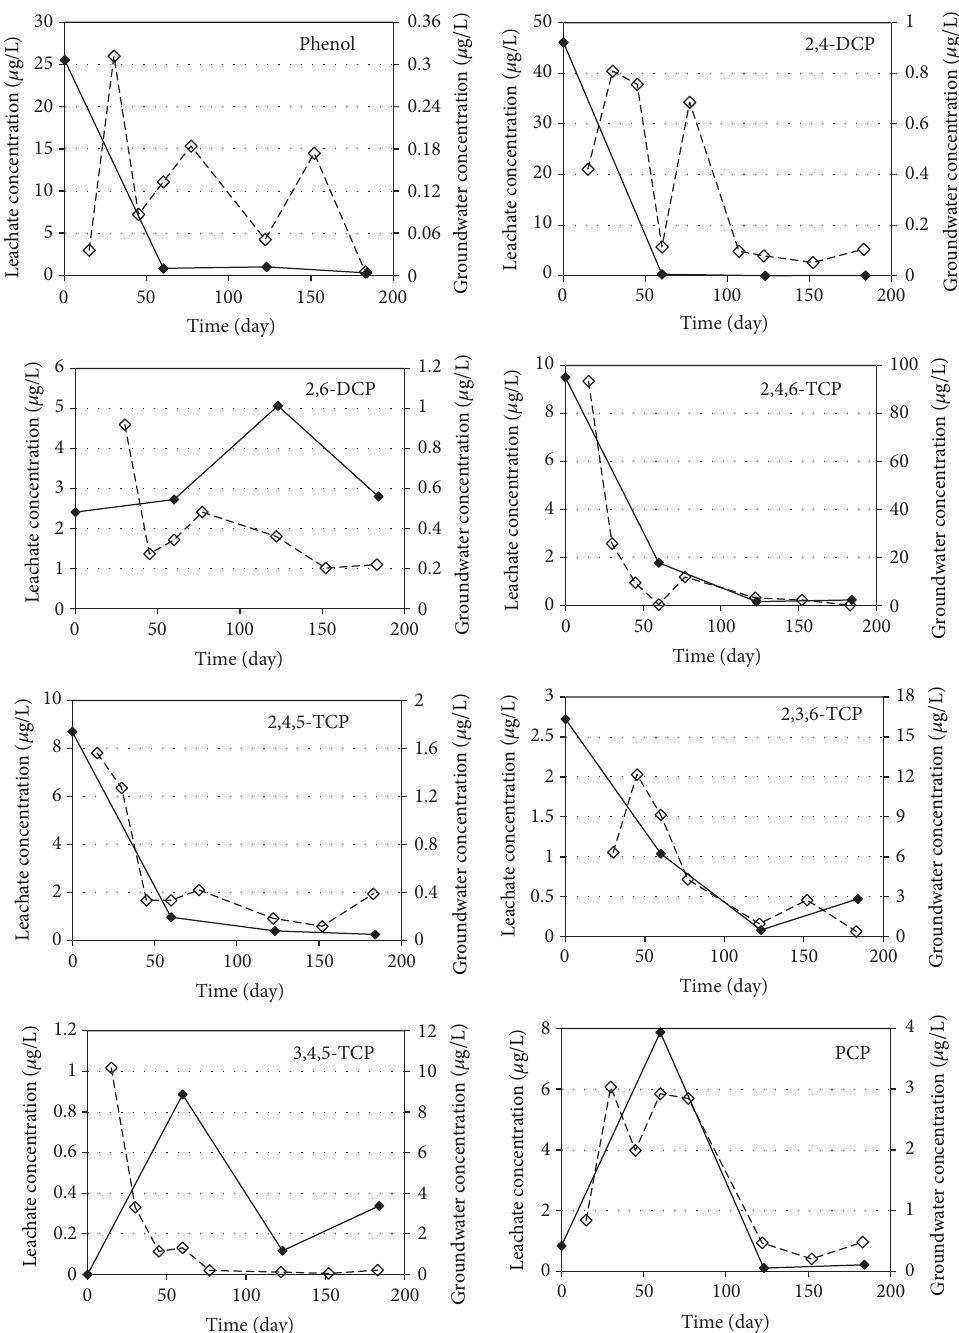
Figure 2: Variations of the phenolic compounds in groundwater and leachate samples of R1 reactor (——: leachate concentration, -----: groundwater